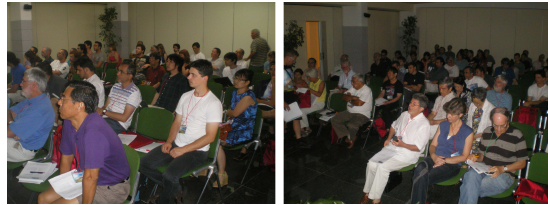
Figure 3: Scientific talks: the discipline of conference participants in attending was great.